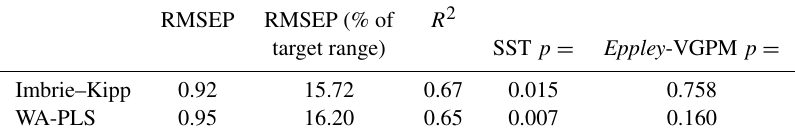
Table 3. Cross-validated root mean square error of prediction (RMSEP) as absolute values and relative to the range of the target variable, as well as the coefficient of determination. The results of the significance analysis after Telford and Birks (2011) from both transfer function methods are given; p indicates the statistical significance against the null distribution of 999 random reconstructions. RMSEP RMSEP (% of R 2 target range) SST p = Eppley -VGPM p = Imbrie–Kipp 0.92